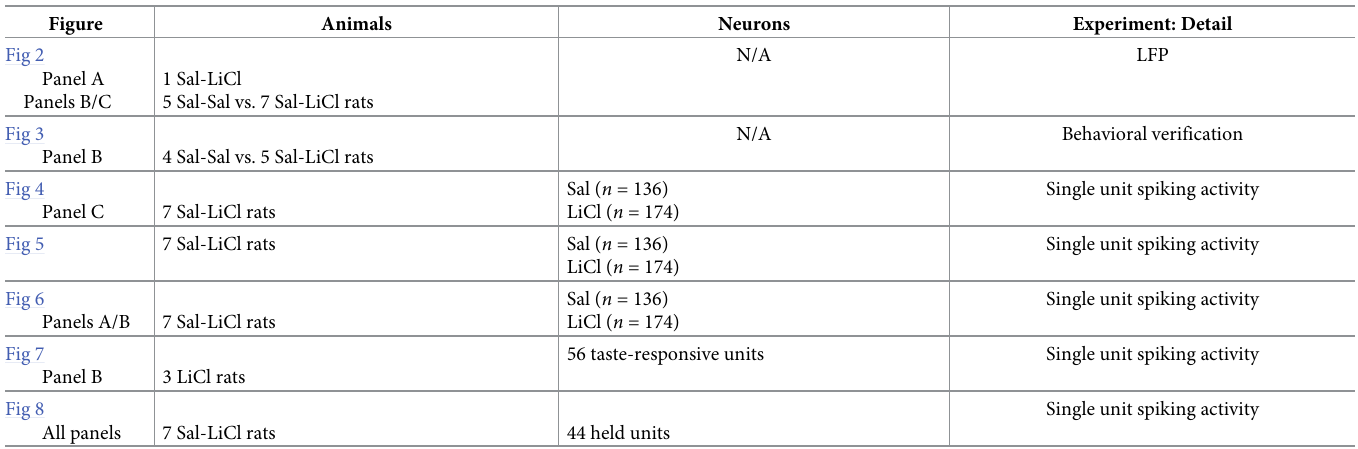
Table 1. Animal assignment in each figure. Figure Animals Neurons Experiment: